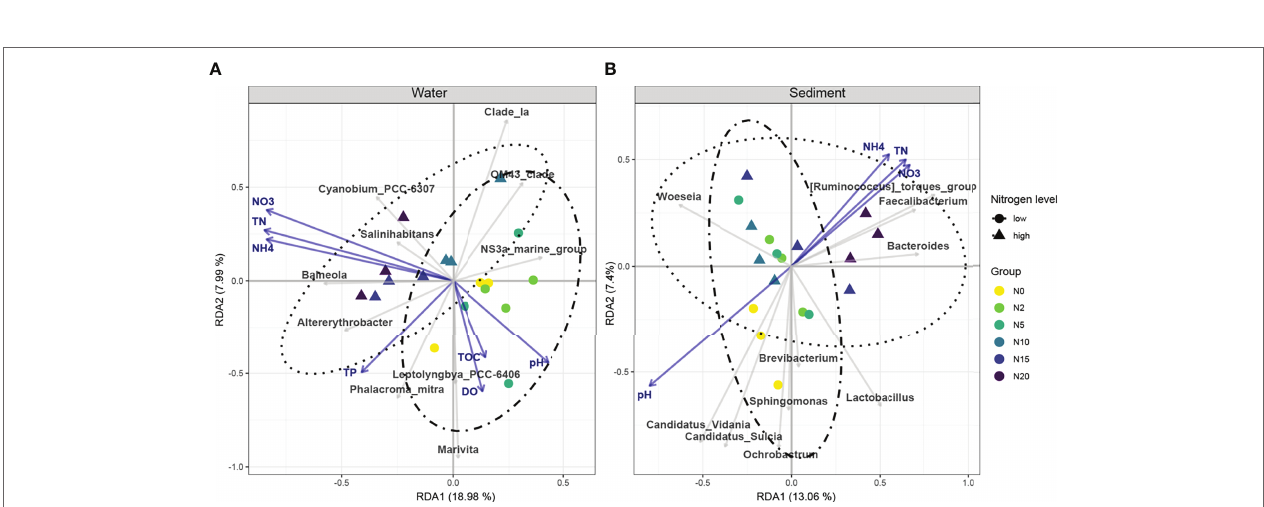
FIGURE 4 | Redundancy analysis (RDA) demonstrating the relative influence of environmental factors on the bacterial communities in water (A) and sediment (B) . Only those factors identified to significantly influence bacterial communities are shown in the RDA. Samples were grouped according to nitrogen level. Different groups are displayed in different colors and shapes. Similarity values among the sample groups are represented by the distances between them in each graph. Blue arrows indicate the environmental factors; gray arrows indicate the bacterial